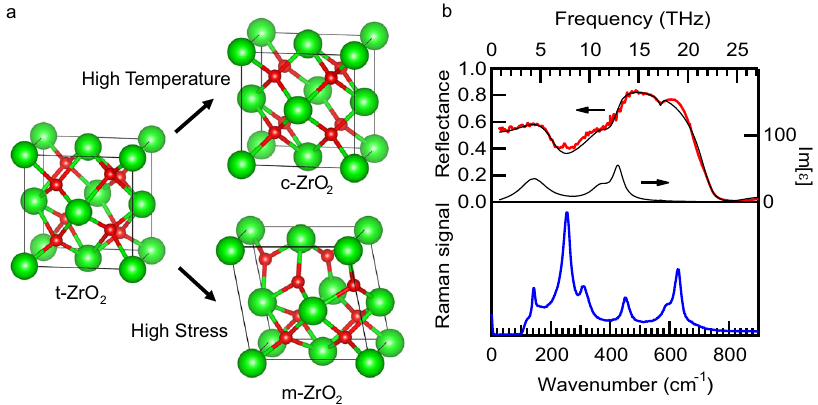
Fig. 1 Phase transformation of t-ZrO 2 . a The crystal structures of t-, c-, and m-ZrO 2 . The green and red spheres correspond to Zr and O atoms, respectively. b Infrared re fl ection spectrum (red curve) and Raman spectrum (blue curve) for the sintered 3.5-mol% Y 2 O 3 -stabilized zirconia plate, which mainly shows characteristics of the tetragonal phase. The imaginary part of the dielectric constant was determined from the re fl ection spectrum with the assumption of four Lorentz